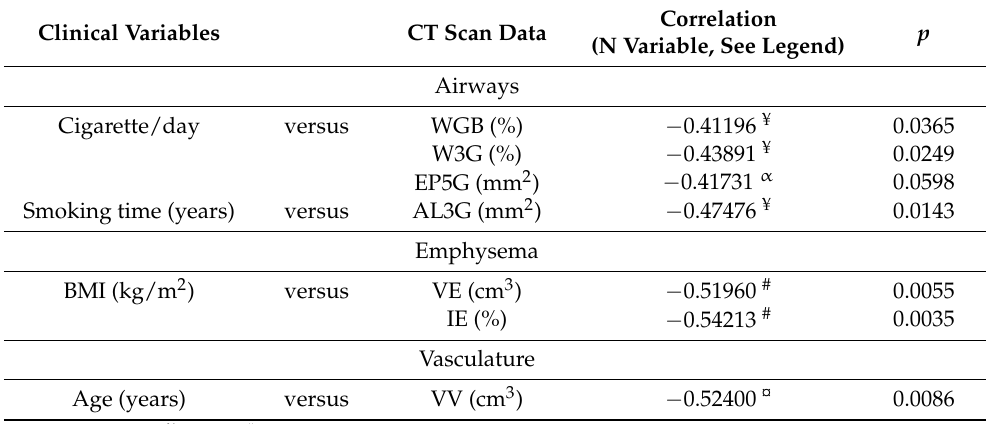
Table 3. Correlation analysis of clinical data versus CT scan